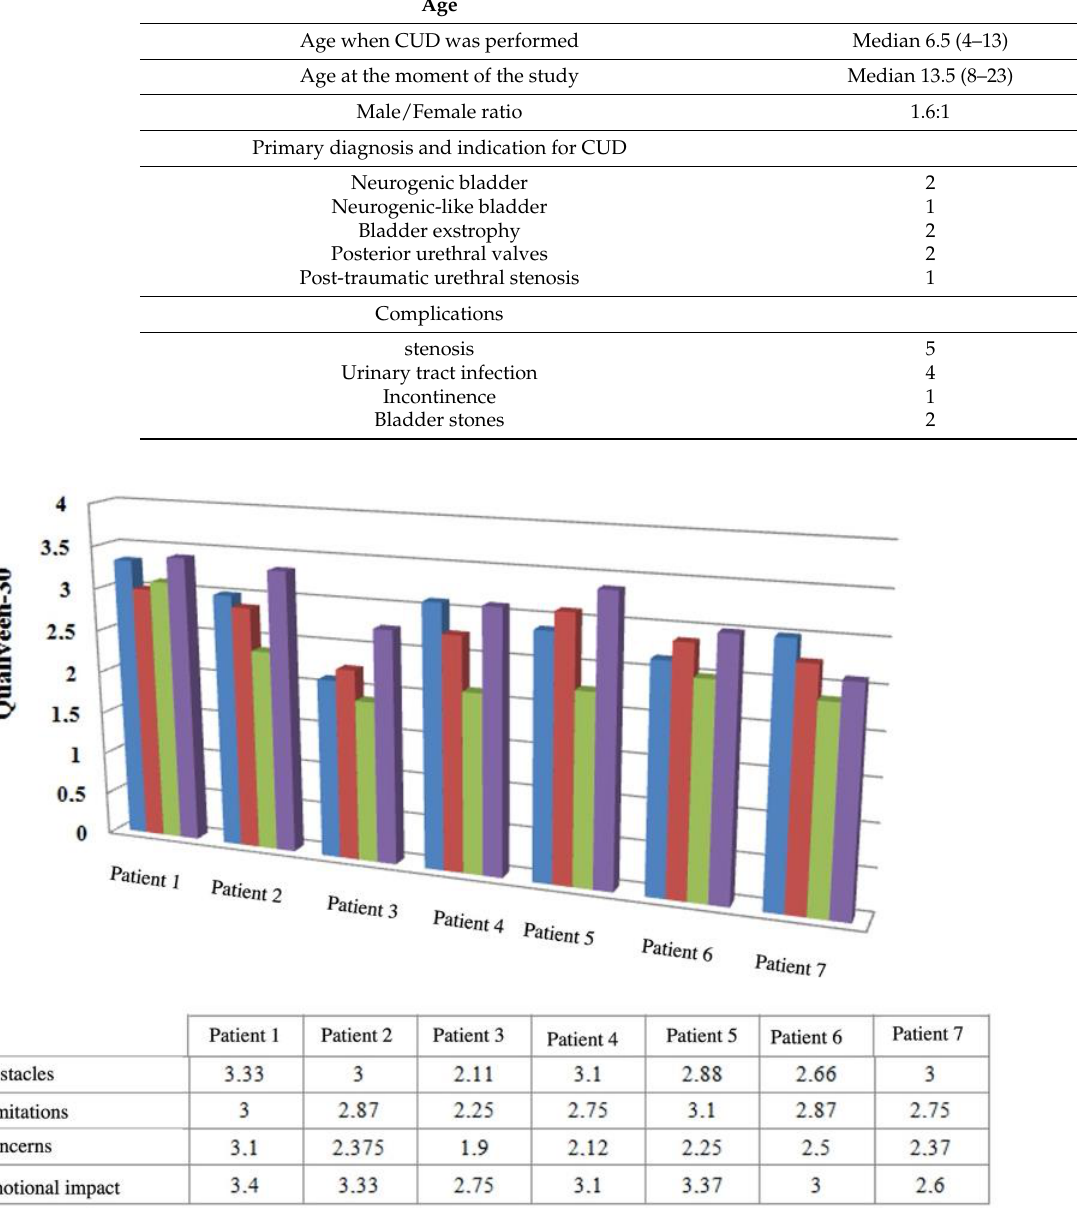
Figure 2. Qualiveen questionnaire results.